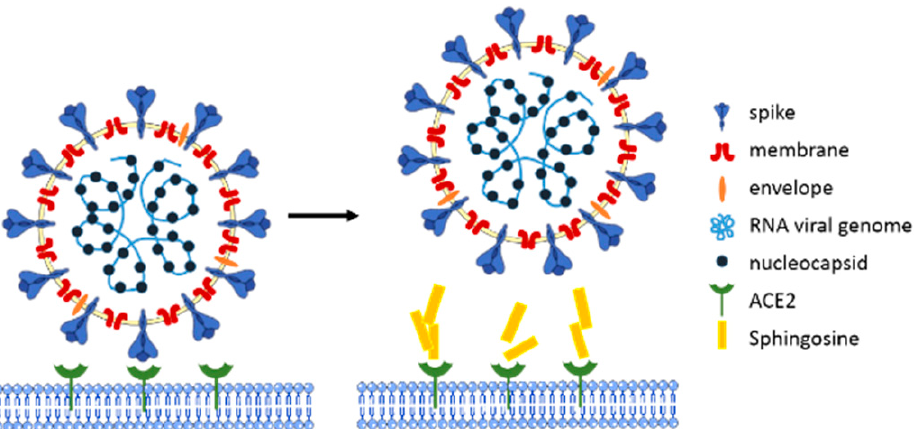
Figure 3. Model of how sphingosine prevents SARS-CoV-2 infection. Exogenous sphingosine application in human nasal or Vero-E6- epithelial cells results in the binding of sphingosine and angiotensin-converting enzyme 2 (ACE2) receptor, which is required for severe acute respiratory syndrome coronavirus-2 (SARS-CoV-2) infection. Sphingosine thereby prevents the recognition and interaction between the spike protein of SARS-CoV-2 and the host’s ACE2 receptor and ultimately protects the cells from infection.